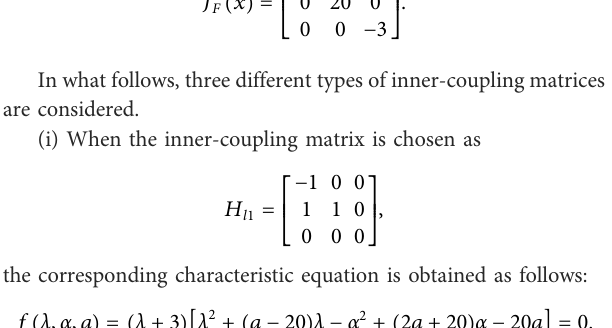
parameter a and its boundary curves are given as shown in Figure 1A. The cyan-shaded area denotes the synchronized region in which λ m ( α ) < 0. The magenta line denotes the corresponding boundary curve. These notations will be used for Figures 1B, C and Figure 2.